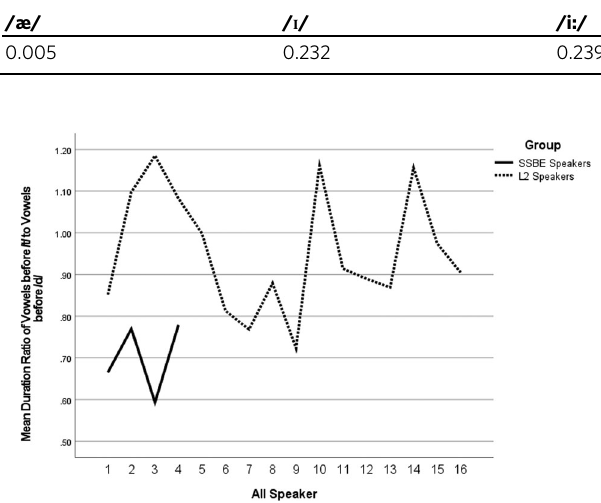
Fig. 2 English Variation. Variation among the duration ratios produced by the native and nonnative English